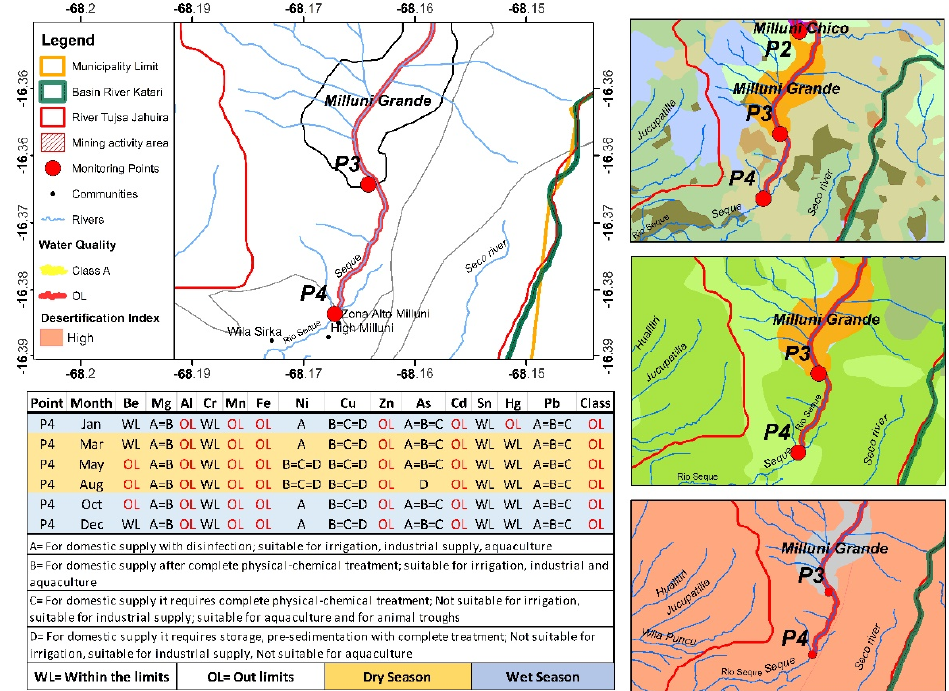
Figure 7. Water quality classification according to parameters monitored in P4—Milluni Basin.